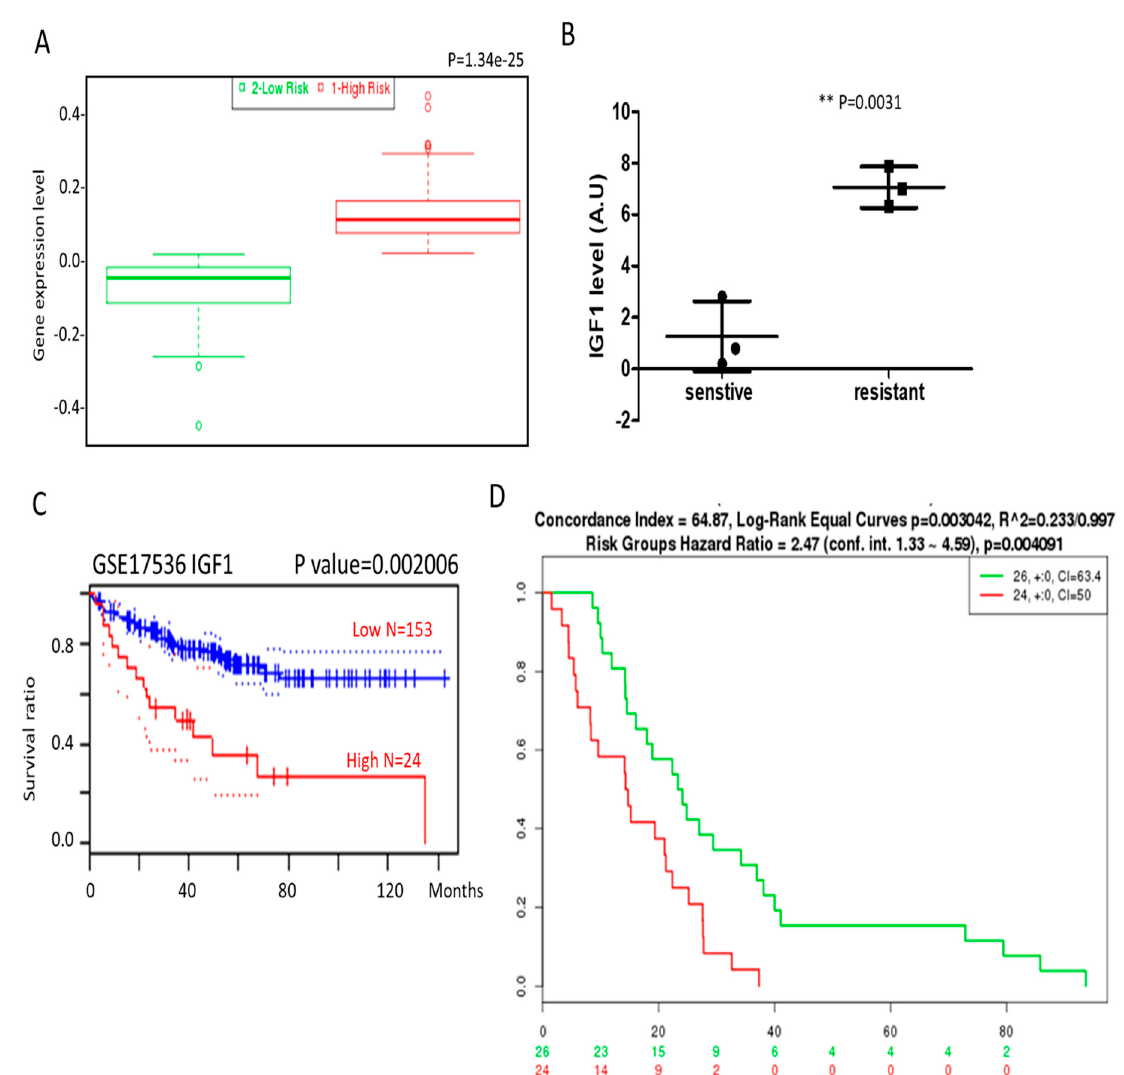
Figure 2. Increased IGF1 and β -catenin expression is associated with a higher incidence of colon cancer and poorer prognosis. ( A ) Using the SurvExpress database, we found that an increased IGF1 mRNA level was associated with a higher risk of developing colon cancer. ( B ) Our GEO (Gene Expression Omnibus) database analysis showed that a significantly higher level of IGF1 mRNA was detected in methotrexate-resistant colon cancer cells than the more sensitive counterparts. ( C ) The Kaplan-Meier survival curve obtained from a small cohort (N = 177) showed that increased IGF1 expression is significantly associated with a lower survival ratio in patients with colon cancer. ( D ) Disease-free survival (DFS) analysis of the GSE14333 cohort indicates a shorter DFS in patients with colon cancer expressing a higher level of both IGF1 and β -catenin (CTNNB1). (** p ≤ 0.01 as statistically significant).